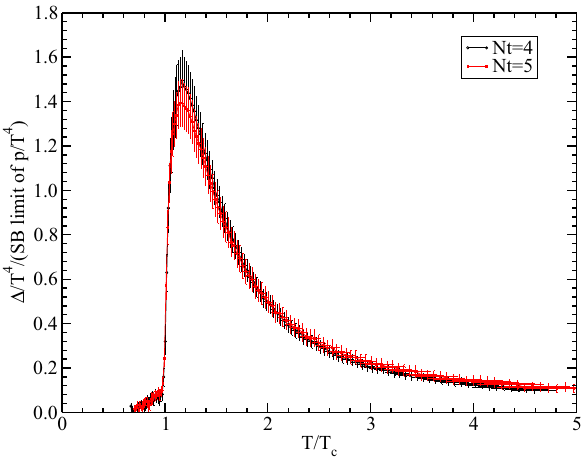
Fig. 11 Scaling of the susceptibility of the Polyakov loop for N τ = 4